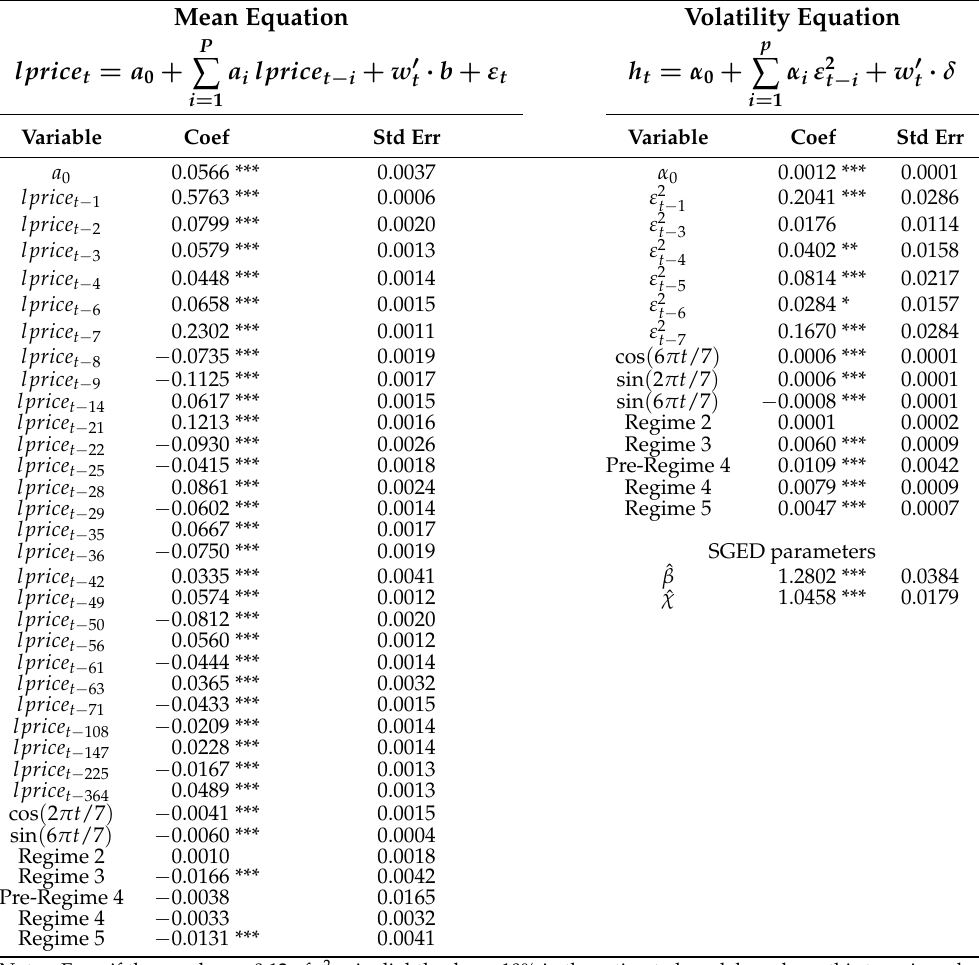
Table 2. Estimation results when assuming